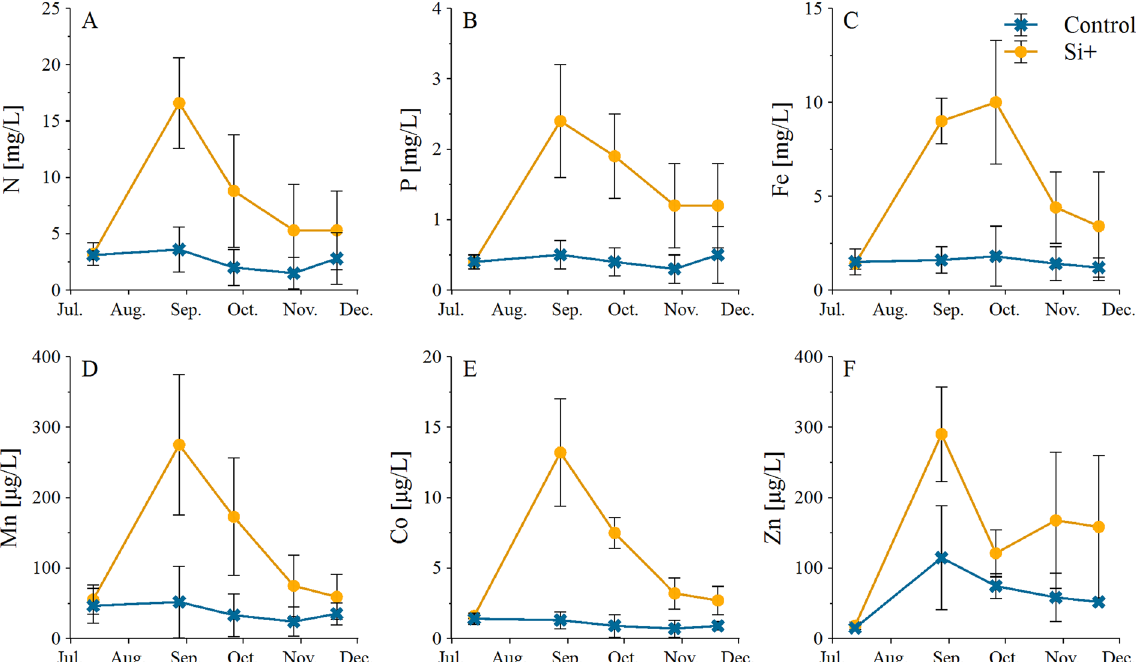
Figure 2. Mean ± SD values of N, P, Fe, Mn, Co, and Zn concentrations in pore water under high (Si + ) and low (control) Si availability, n = 4. Note that N, P, and Fe concentrations are plotted in mg/L, whereas Mn, Co, and Zn are plotted in µ